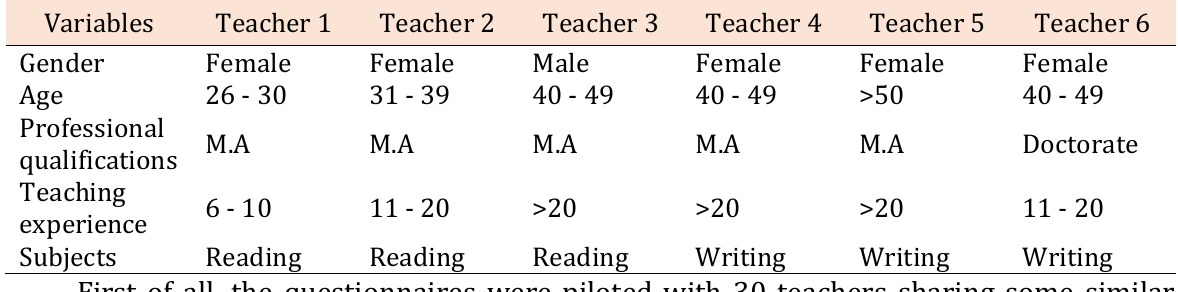
Table 2. Participants for the